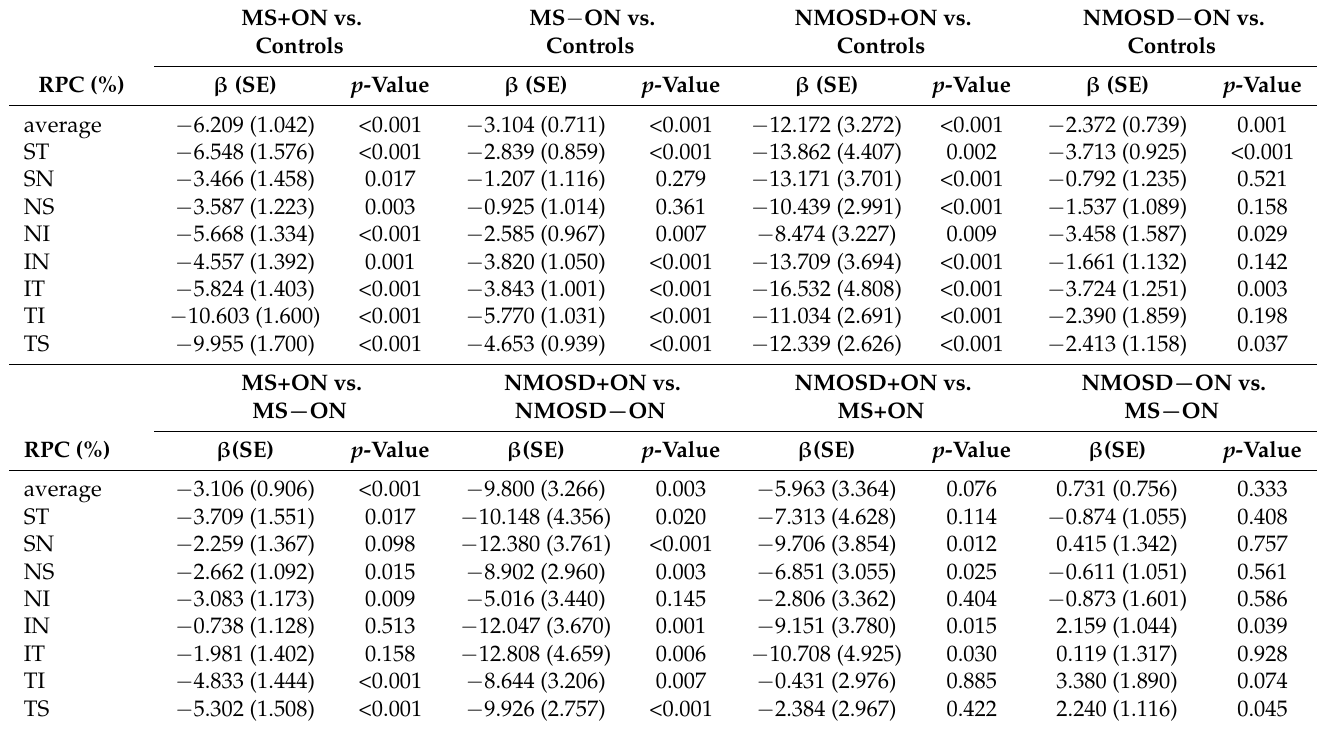
Figure 3. Comparison of the sectoral RPC vessel density and RNFL thickness. The color- and pattern-coded sectors illustrate the significant differences ( p < 0.05) of the corresponding RPC (pink) and RNFL (lines) between patients and controls (top row) and between selected groups (bottom row). The exact p -values are presented in Tables 3 and 4. IN = inferior nasal; IT = inferior temporal; MS = multiple sclerosis; NI = nasal inferior; NMOSD = neuromyelitis optica spectrum disorder; NS = nasal superior; ON = optic neuritis; RNFL = retinal nerve fiber layer; RPC = radial peripapillary capillaries; SN = superior nasal; ST = superior temporal; TI = temporal inferior; TS = temporal superior. Table 4. Differences in RPC vessel density among patients and